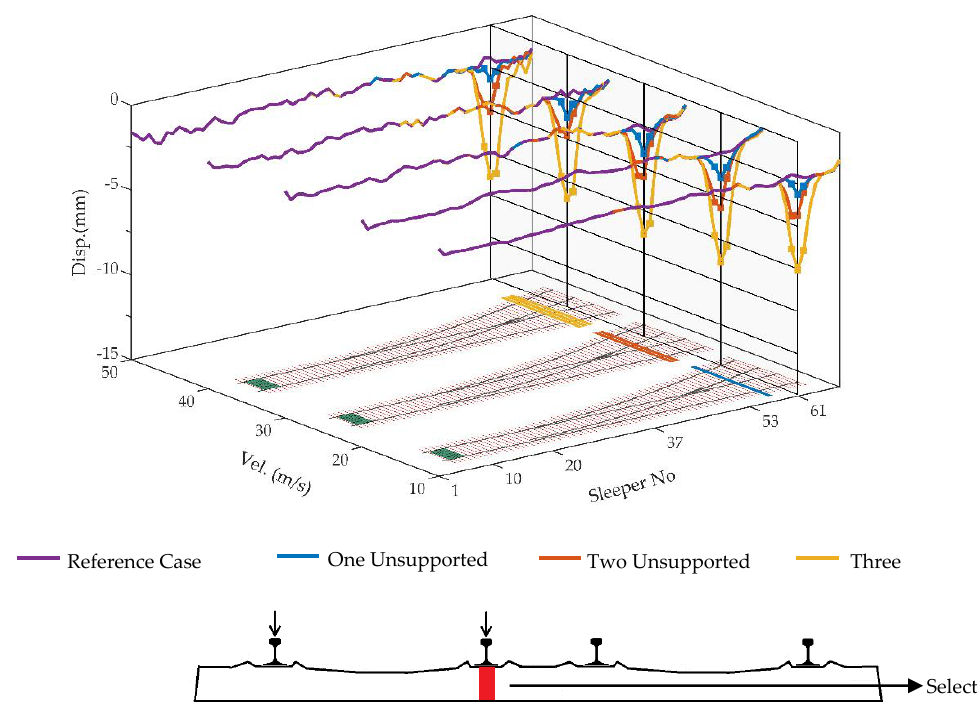
Figure 7. The maximum displacement of bearers at rail seats when an unsupported bearer exists under crossing nose.